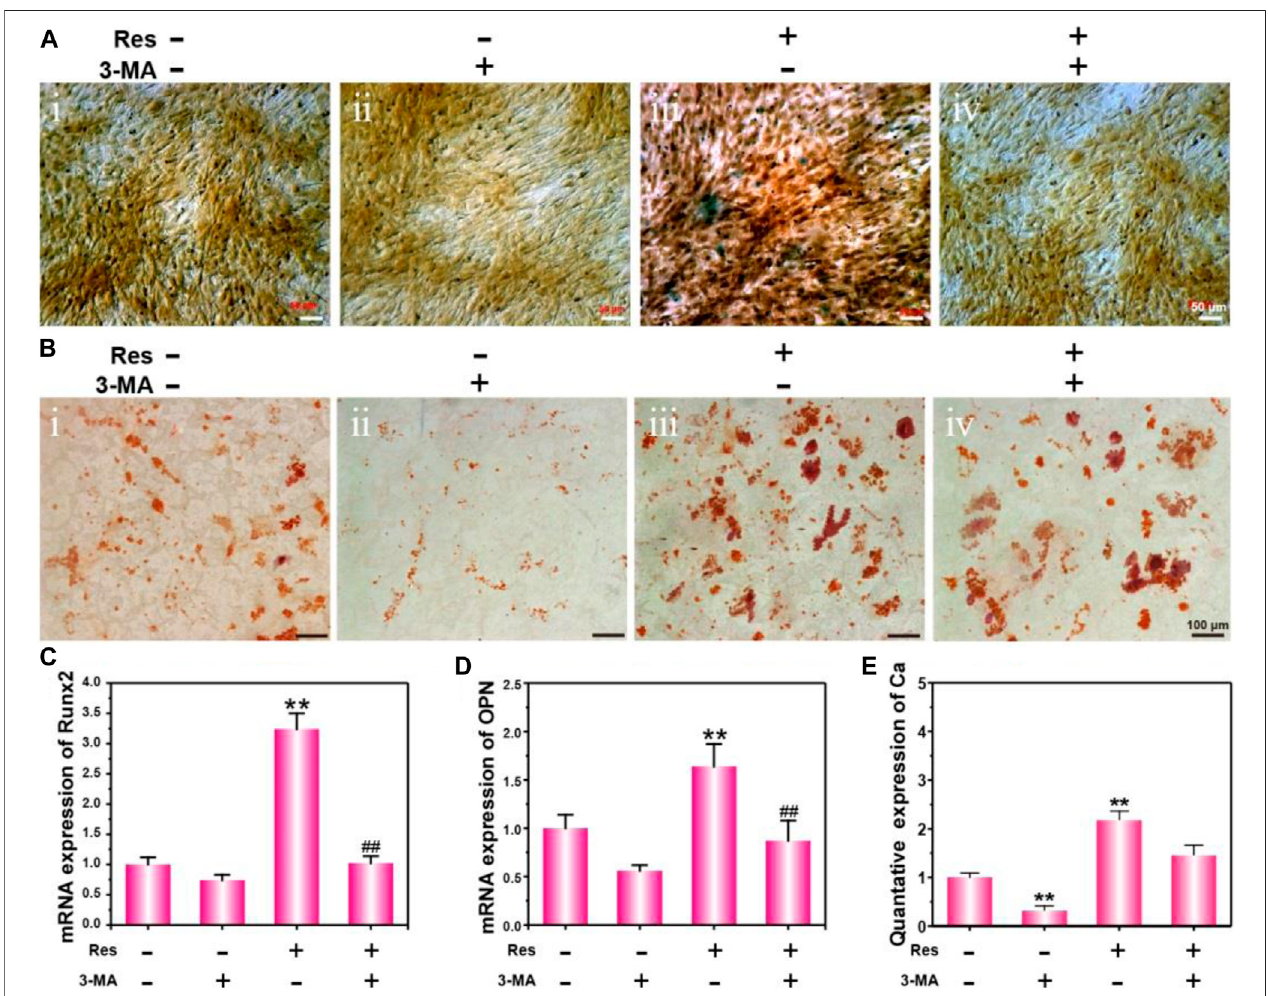
FIGURE4 | CLSM observation ofLC3 puncta (A) , AO-EB staining (B) , fl owcytometry analysis ofthecell cycle (C) , apoptosis (D) , and statistical analysisofthe cell cycle (E), and apoptosis (F) . The values are represented as the mean ± SD ( n (cid:1) 3). * p < 0.05, ** p < 0.01 vs control (without Res and 3-MA).